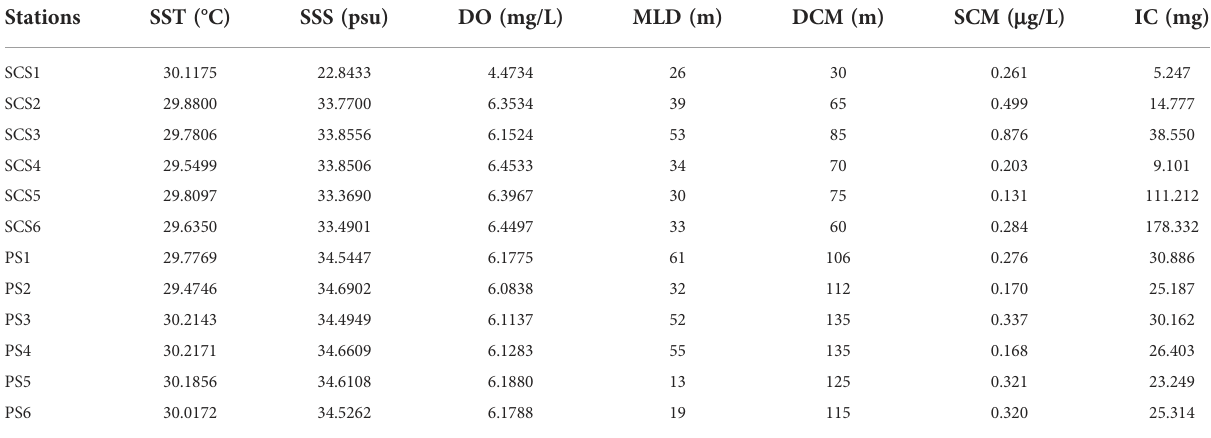
TABLE 2 Summary of environmental factors at different